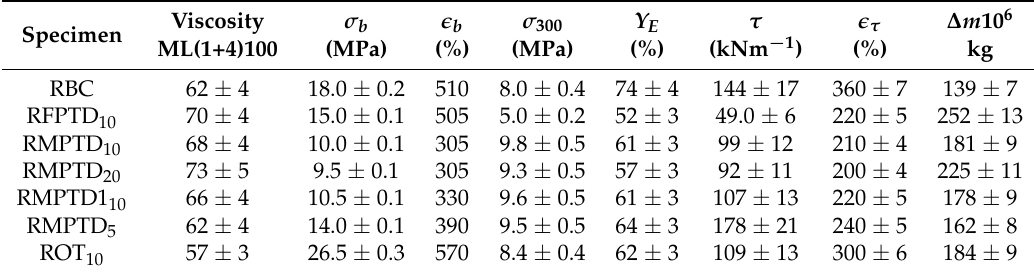
Table 4. Mechanical characteristics of reinforced rubber compounds. Experimental error for each value is calculated as standard deviation of repeated